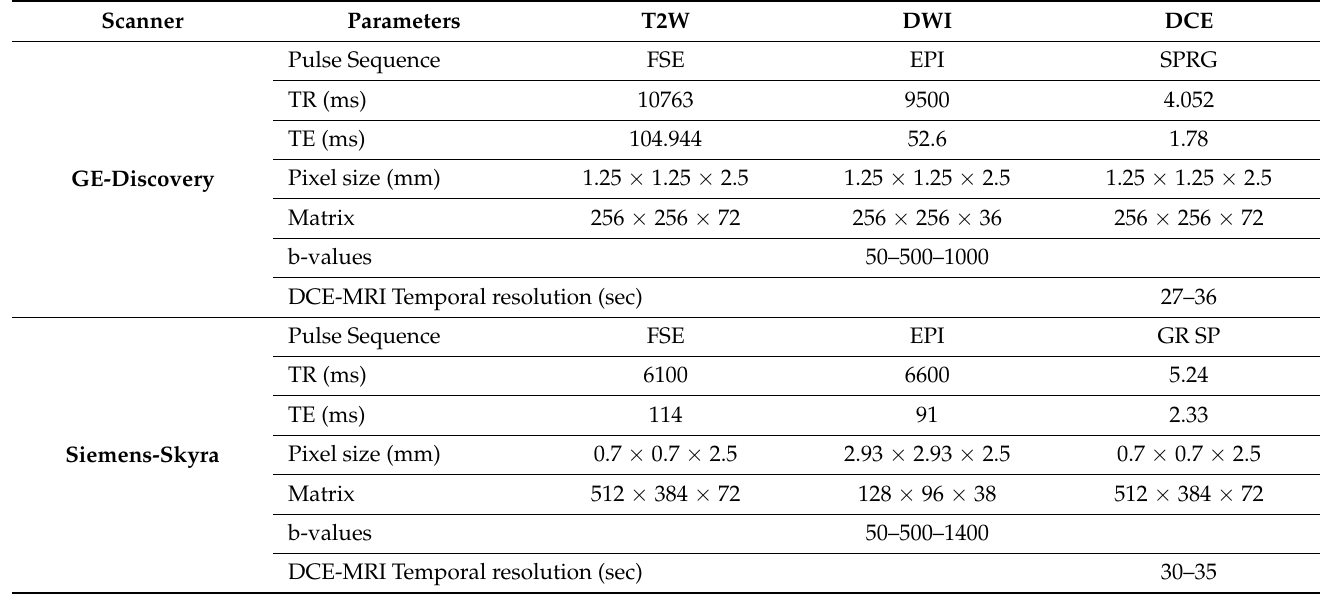
Table A1. MRI acquisition parameters for mpMRI sequences.